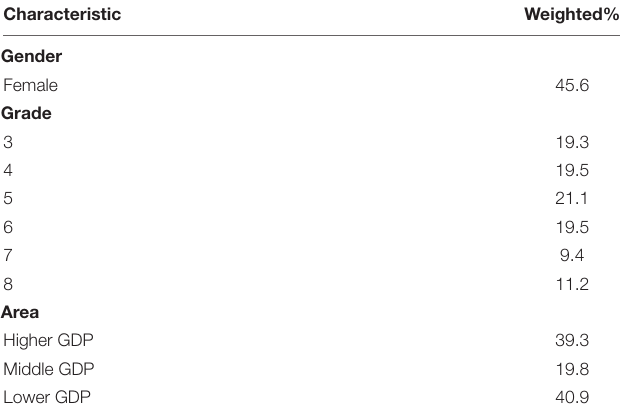
TABLE 1 | Weighted demographic characteristics of